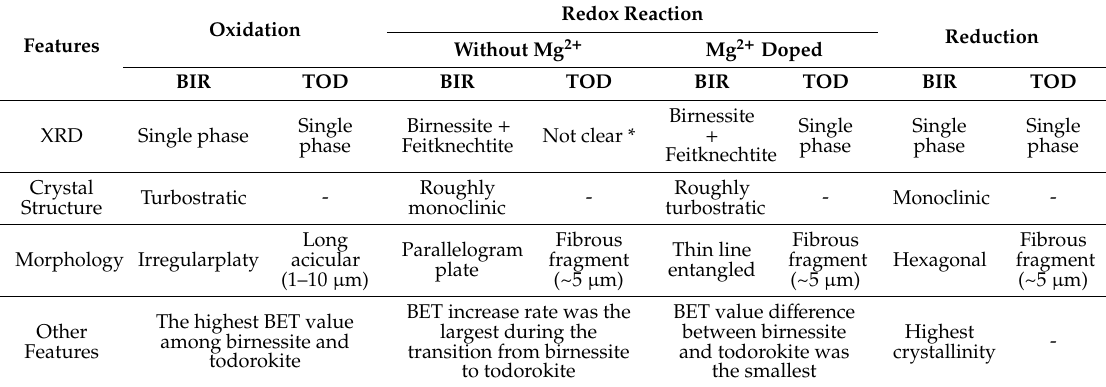
Table 3. Summary of the characteristic features of the birnessite and todorokite samples synthesized through di ff erent